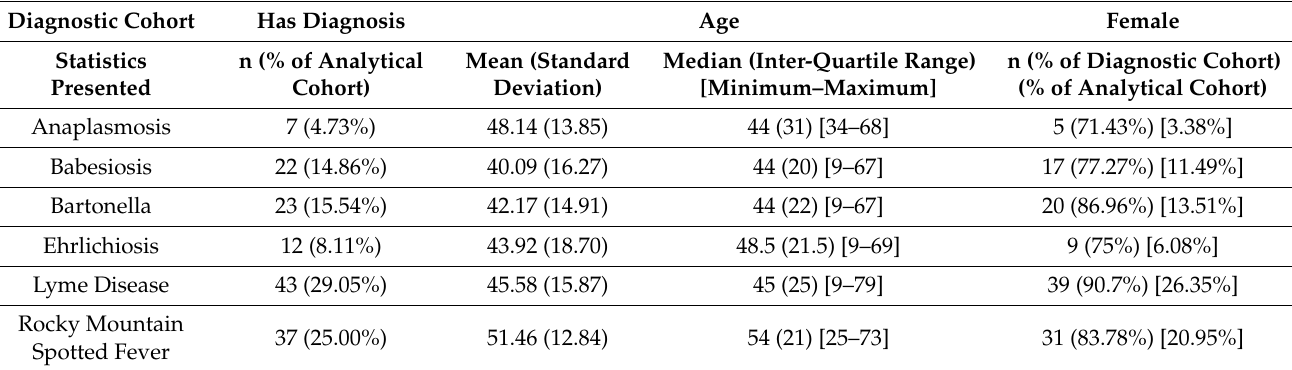
Table 18. Respondent Characteristics by Diagnostic Category. Summary statistics for the number of respondents, and their age and sex, who reported a tick-borne disease are provided for each disease (i.e., by diagnostic